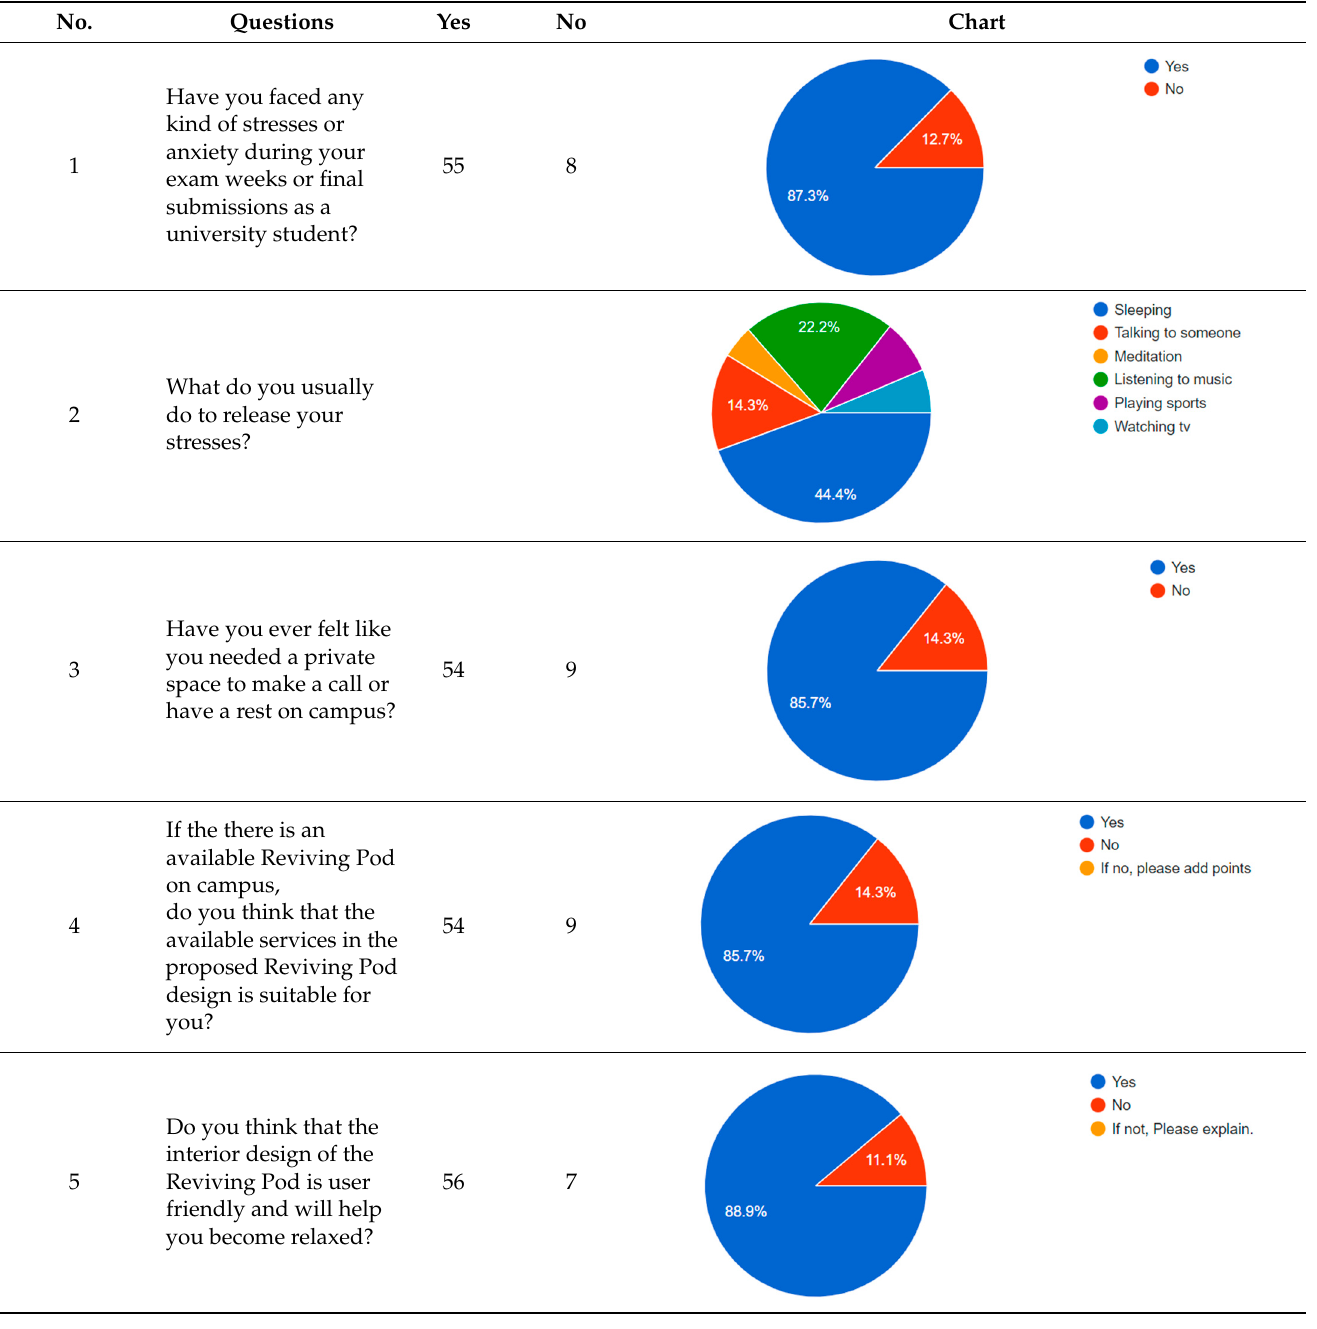
Table A1. Responses of 63 students at Dar Al Uloom University (Section 1 of the survey: The “REVIVING POD”: Design), created by the authors.